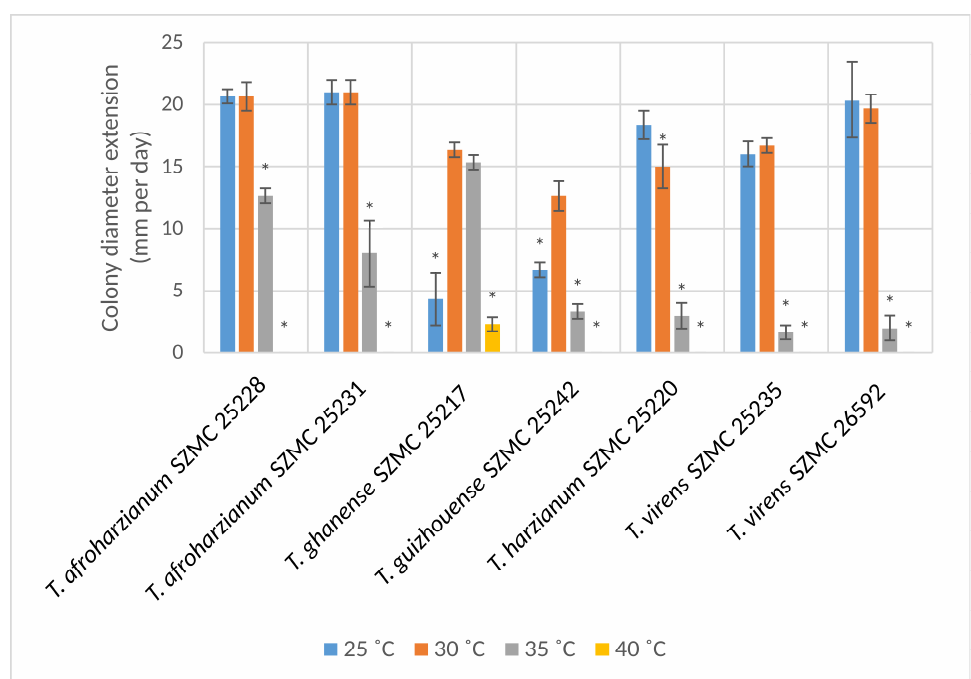
Figure 2. Colony diameter extension rates of the tested Trichoderma strains at different water activity values (mean ± SD, n = 3). Asterisks (*) indicate statistically significant ( p ≤ 0.05) differences in rela- tion to the colony diameter extension rate of the respective strain at the water activity optimum (a w 0.997).